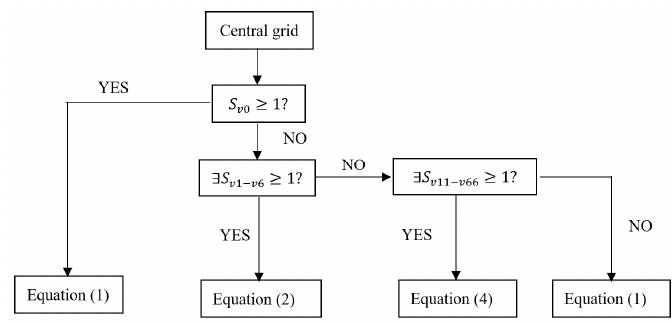
Figure 3. Simulation block diagram of the CA model.